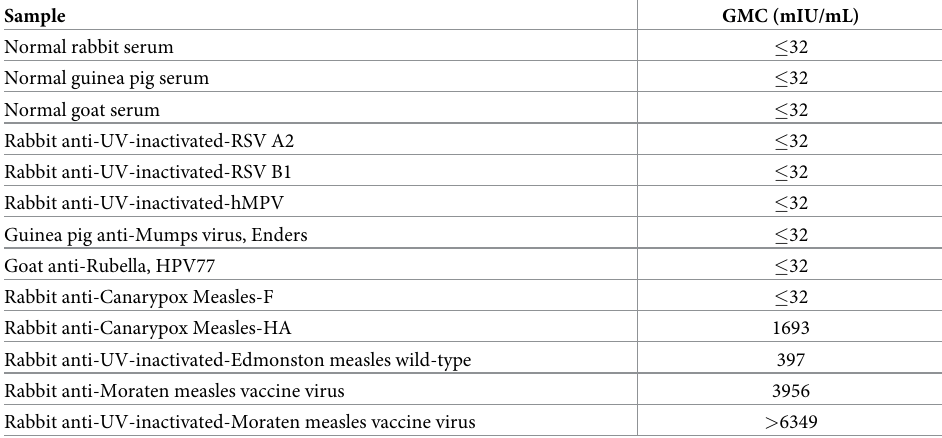
Table 2. Specificity of MN-RT-qPCR assay using polyclonal